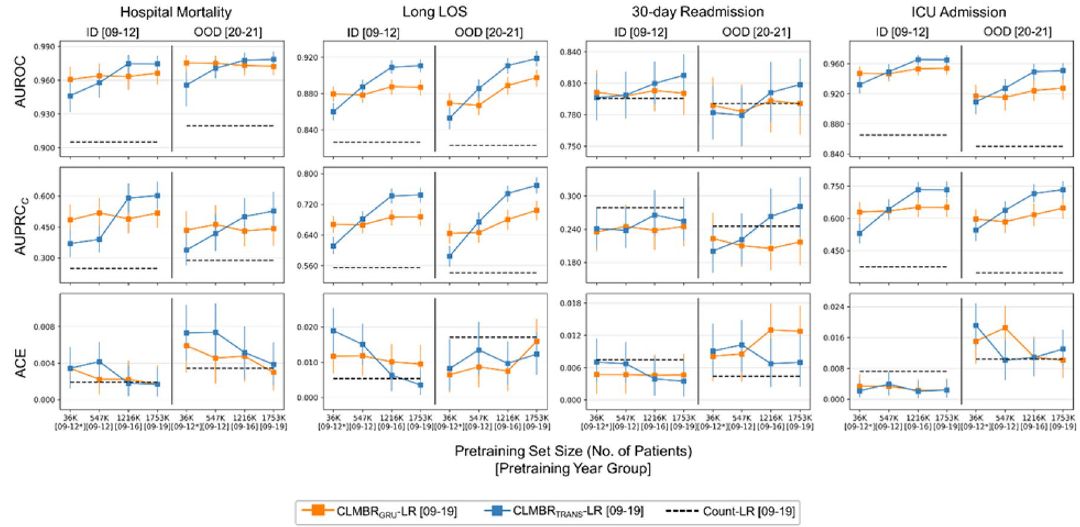
Figure 5. Scaling of GRU- and transformer-based CLMBR along pretraining set size. A more positively sloped curve (negative for ACE) indicates better performance or robustness (performance in the OOD year group) along increasing pretraining set size. Note that the number of patients include both training and validation sets of the pretraining cohort. The asterisk in [09–12*] indicates a subset of patients in [09–12] that have been admitted to an inpatient unit during the year range. Raw performance scores and slopes are provided in Supplementary Tables S6 and S7 online, respectively. AUROC Area under the receiver operating characteristics curve; AUPRC C Calibrated area under the precision recall curve; ACE absolute calibration error; LR Logistic regression; CLMBR Clinical language model-based representations; GRU Gradient recurrent unit; TRANS Transformer; LOS Length of stay; ICU Intensive care unit.